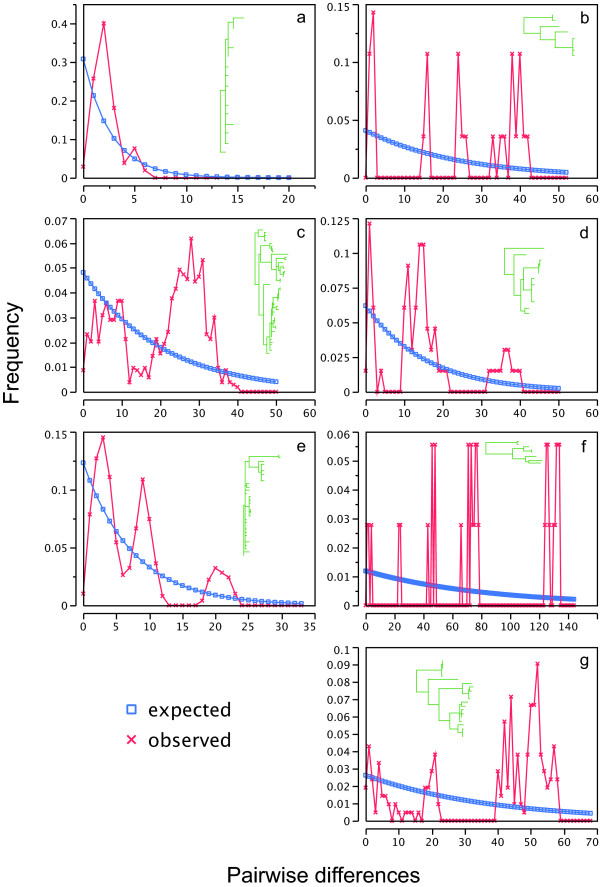
Mismatch distribution plots for major Narceus clades. Observed frequency of pairwise differences versus expected under exponential population growth model for major mtDNA lineages: (a) Northwest, (b) Mississippi/Louisiana, (c) Southeastern, (d) Florida panhandle/southern Appalachian, (e) Northern, (f) Texas/Louisiana, (g) Southern Appalachian. Corresponding clades are shown in the corner of each panel, illustrated in green.